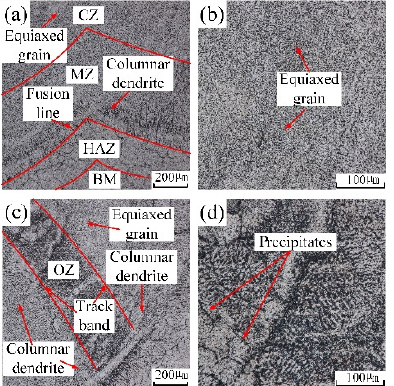
Figure 6. The microstructure in distinctive zones of in-air cladding layer: ( a ) the microstructure near fusion line; ( b ) the local amplification of CZ; ( c ) OZ; ( d ) the local amplification of OZ.